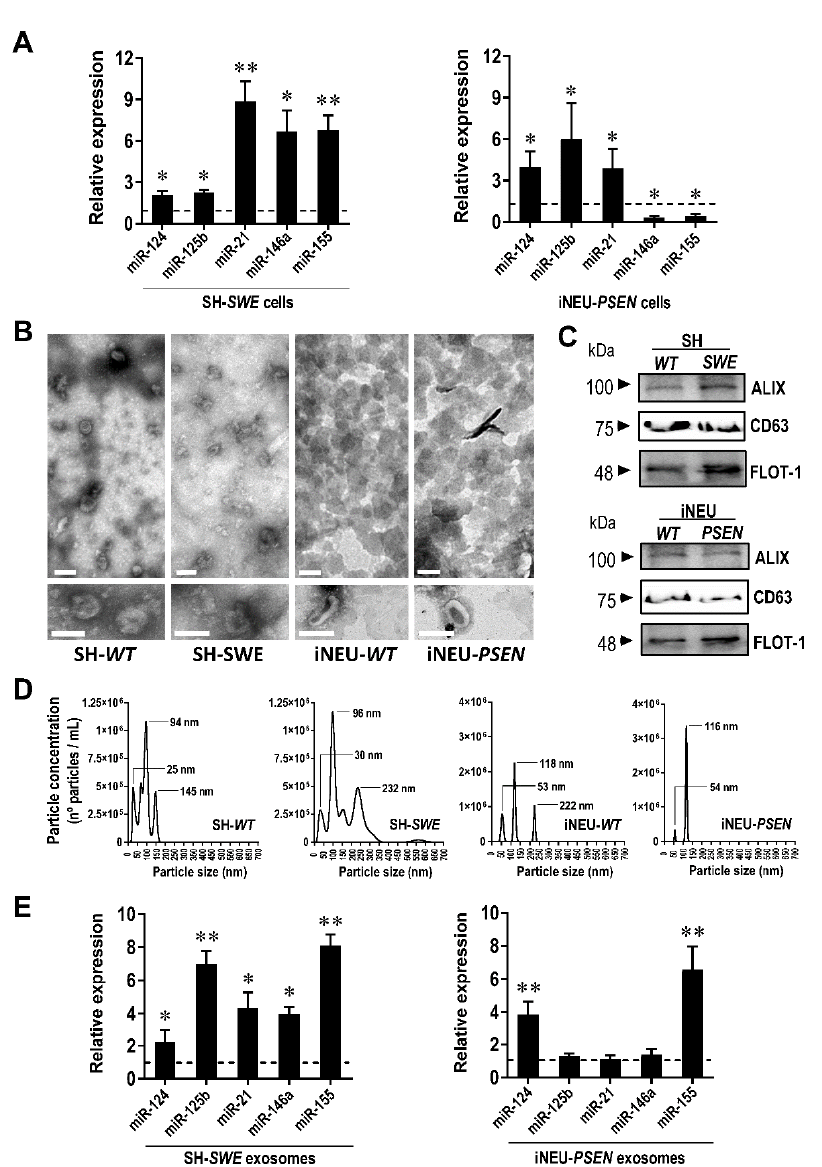
Figure 1. Comparison of inflammatory-associated miRNA (inflamma-miRNA) profiles in SH- SWE and iNEU -PSEN cells, and in their respective exosomes, relatively to their SH- WT and iNEU -WT control samples. Cells were obtained and differentiated as described in Material and Methods. ( A ) Inflamma-miRNAs expression levels in both cellular AD models reveal that miR-124, miR-125b and miR-21 are increased. ( B ) Representative Transmission Electron Microscopy (TEM) images of exo- somes with characteristic sizes after their isolation from cell secretomes by differential ultracentrif- ugation. ( C ) Representative Western blots for the common exosomal protein markers, Alix, CD63